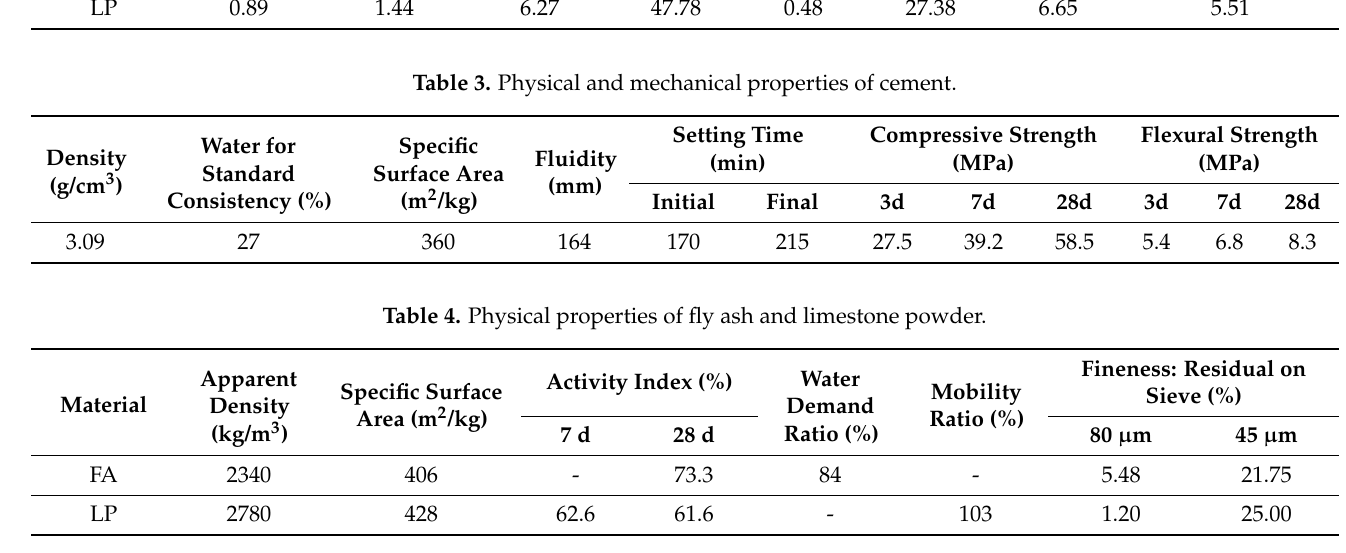
Table 4. Physical properties of fly ash and limestone powder .